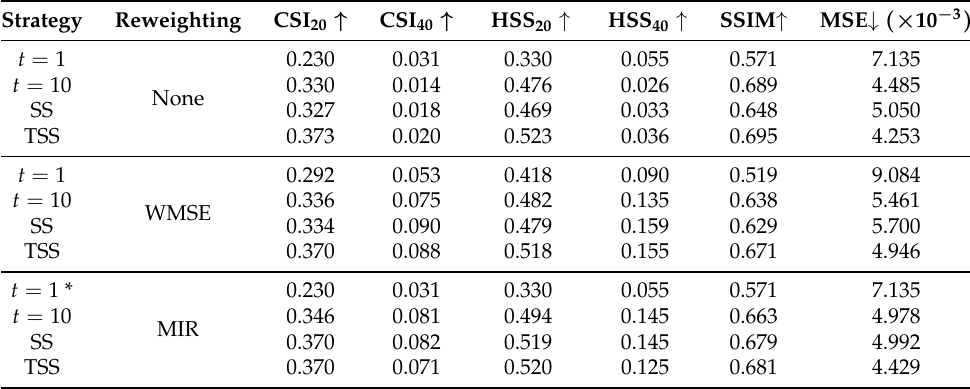
Table 9. Reweighting strategy on the ConvLSTM of the TAASRAD19